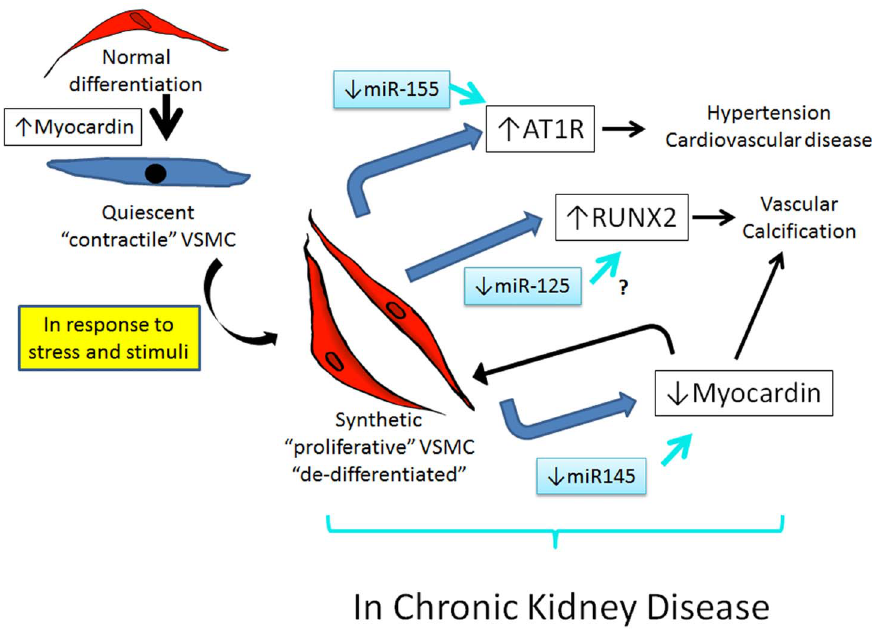
Figure 6. Hypothesis of the impact of vascular miRNAs on the pathogenesis of cardiovascular disease of CKD. This figure is our hypothesis of how the miRNAs may affect cardiovascular disease in CKD. During development, normal differentiation of VSMC is controlled in part by the ‘master’ regulator, myocardin. In adulthood, the majority of VSMC are in a quiescent, synthetic state. During acute insults, these synthetic VSMC change to a more proliferative state, returning to a quiescent state after the insult. However, in the setting of kidney disease, VSMC appear to stay in a more proliferative state with corresponding increased expression of AT1R and RUNX2, and decreased myocardin expression. The decreased expression forces the VSMC to remain in a continual proliferative or de-differentiated state. MiRNAs are known to be important in regulating such differentiation during development, but the low levels of miR-155, 145, and 125b observed in CKD arteries and VSMC and in the circulation of patients with CKD in the present study may lead to further propagation of de-differentiated VSMC, potentiating the development of hypertension, cardiovascular disease and vascular calcification.